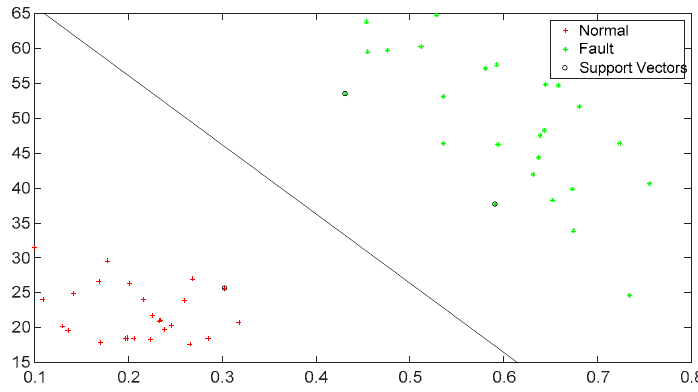
Sensors 2019 , 19 , x Figure 16. Classification result based on support vector machine (SVM) of the proposed method.